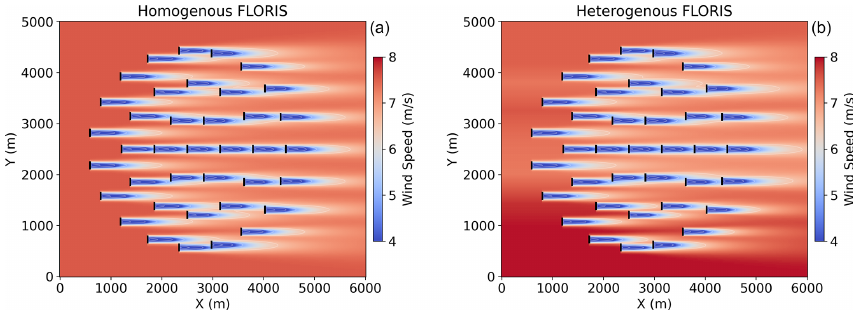
Figure 12. Horizontal cut planes of the FLORIS simulations with wind direction at 270 ◦ . Wake losses were calculated using the homoge- neous FLORIS model (a) and heterogeneous FLORIS model (b) . Turbine rotors are indicated by black lines.